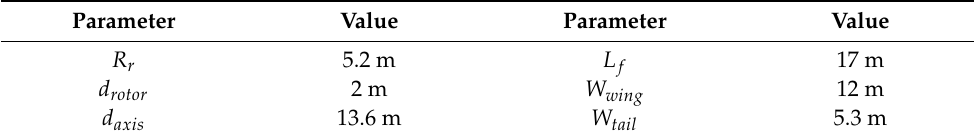
Figure 5. Three views of geometry model of coaxial tilt-rotor aircraft. Table 2. Numerical values of the geometry parameters of the coaxial tilt-rotor aircraft model.